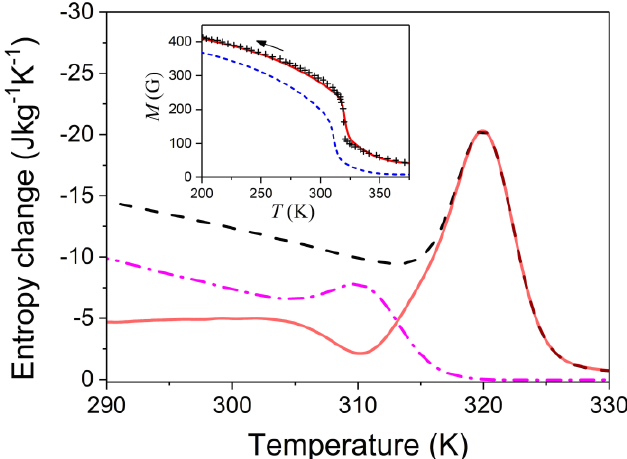
Figure 5. Entropy functions computed for the field values of 5 T (dashed line) and 1 T (dash-doted line). Solid line depicts the difference of these functions, that is the magnetic-field-induced entropy change. Inset: Experimental values of magnetization of Ni 50 Mn 18 Ga 25 Cu 7 ribbon in the magnetic field of 5 T (symbols, extracted from Ref. [5]) and theoretical curves computed for the field values of 5 T and 1 T (solid and dashed lines, respectively).